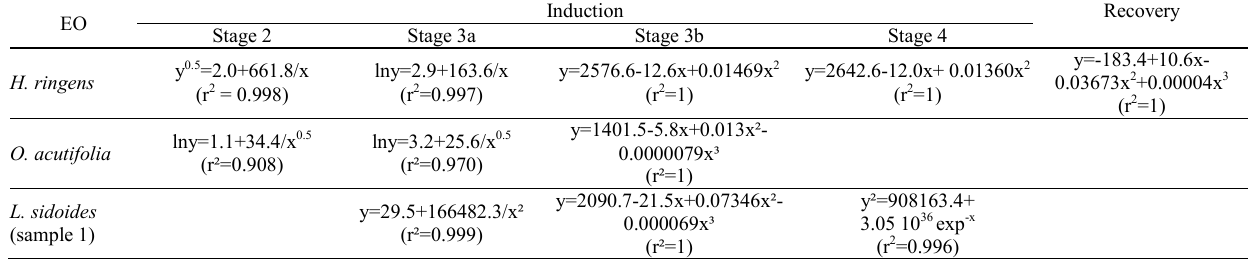
Table 2. Relationship between the time required to reach the stages of induction and recovery from anesthesia and the concentration of the essential oils (EOs) of Hesperozygis ringens , Ocotea acutifolia and Lippia sidoides in silver catfish. Where x=concentration of essential oil (µL L -1 ); y=time to reach the stage of induction or recovery from anesthesia (Schoettger & Julin, 1967) in seconds